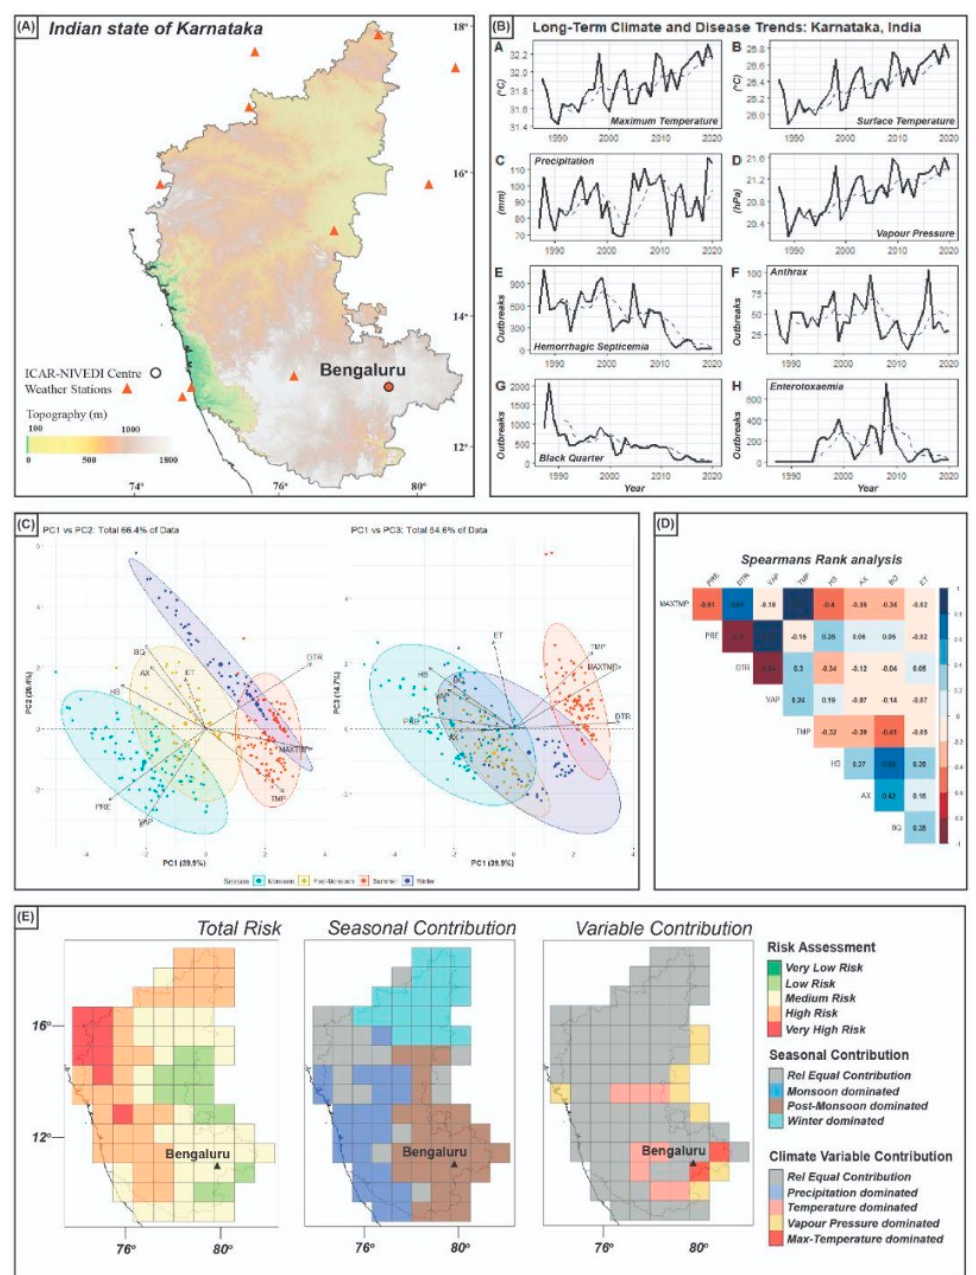
Figure 2. Generalized output for risk-mapping model, using state of Karnataka as an example: ( A ) Location map for Karnataka; ( B ) time-series graphs for both climate variable data and disease outbreak data; ( C ) PCA results for combined data; ( D ) Spearman’s rank correlation statistics between climate and disease data; ( E ) final risk map output with seasonal contribution to risk, and individual variable contribution to risk also mapped in grid-box format. Data presented is modified from